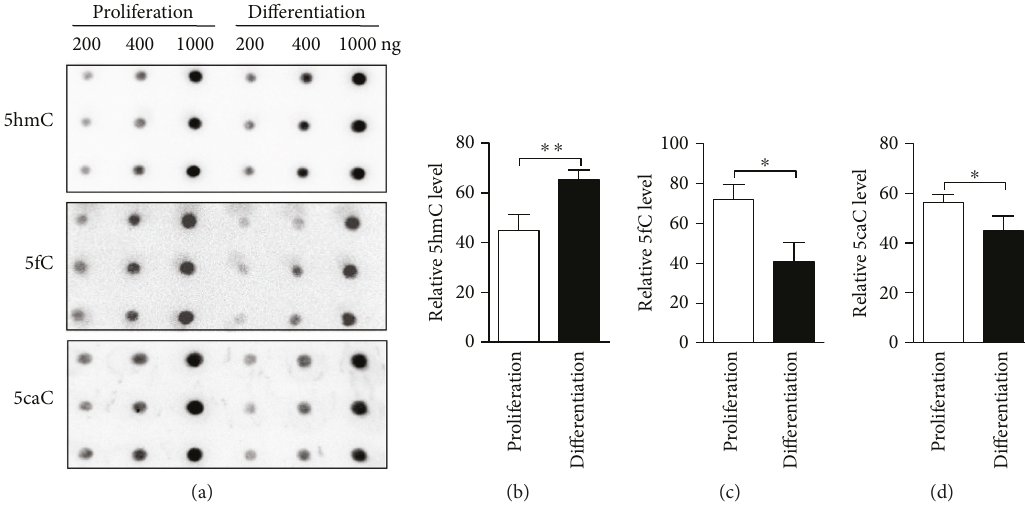
Figure 6: DNA demethylation in cultured aNSCs. DNA dot blots of 5hmC, 5fC, and 5caC in proliferating and di ff erentiated aNSCs (a). The quanti fi cation of dot blots of 5hmC, 5fC, and 5caC, respectively ((c) – (d)). Statistically signi fi cant di ff erences are indicated: ∗ p < 0 05 and ∗∗ p < 0 01